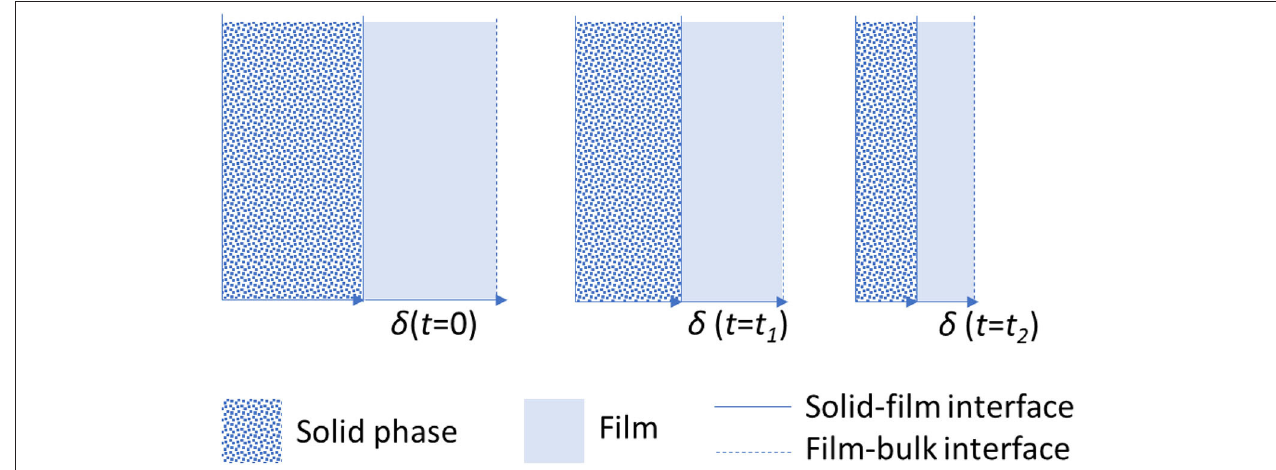
FIGURE 1 | Solid-liquid reaction system: evolution with time of the shrinking solid and shrinking